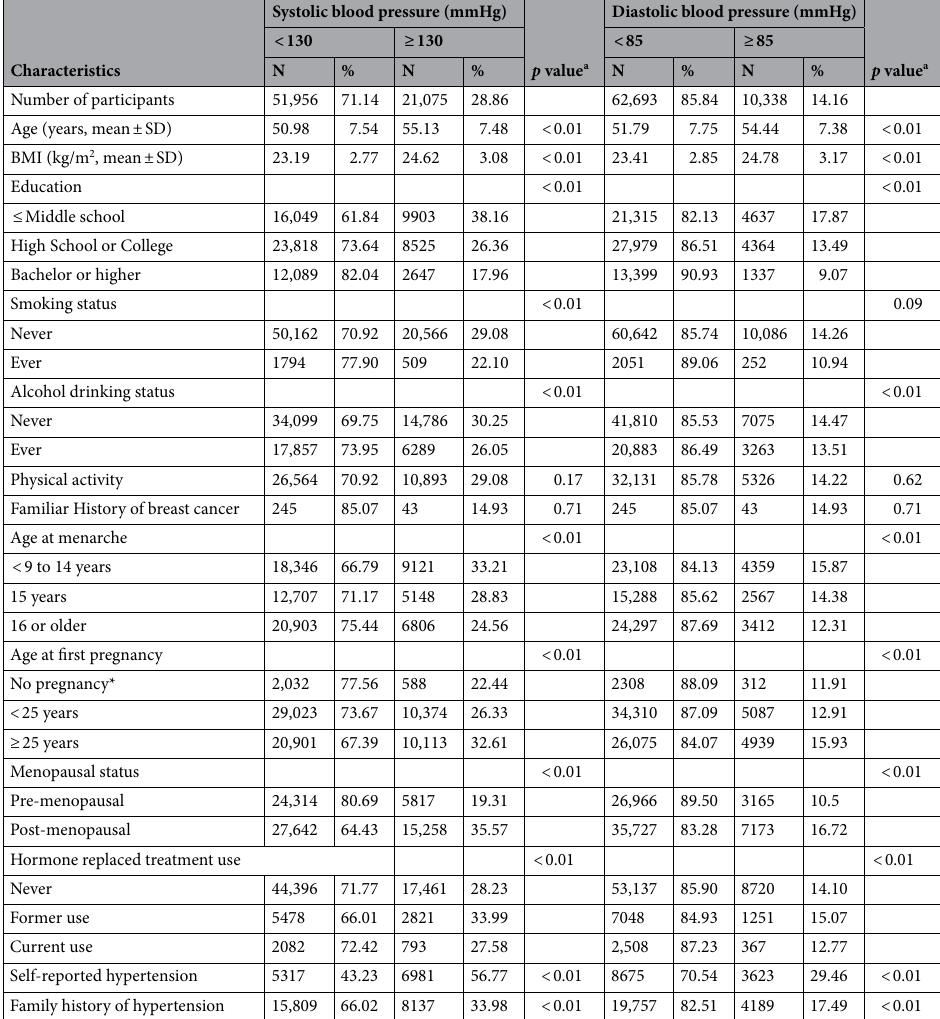
Table 1. Baseline characteristics of the HEXA-G study population by SBP and DBP binary categorization (N = 73,031). HEXA-G Health Examinees Study-Gem, SBP systolic blood pressure, DBP diastolic blood pressure, BMI body mass index, SD standard deviation. Variable distributions are reported as n(%) unless otherwise specified. a Student’s t-test for continuous variables; Chi-square test for categorical